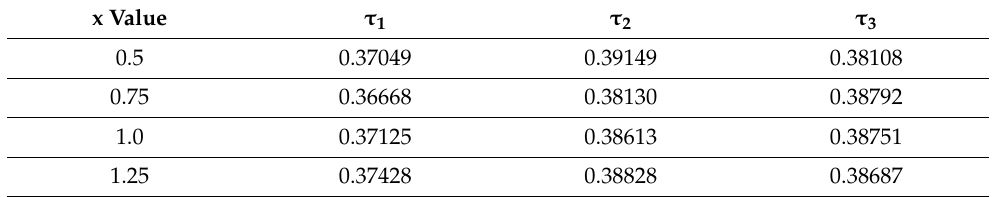
Figure 8. Comparison of the measured and simulated results of the decay time curves. Table 1. Fitting results of the decay time curves for Ca x Mg 2-x Si 2 O 6 :0.025Eu 2+ phosphors.